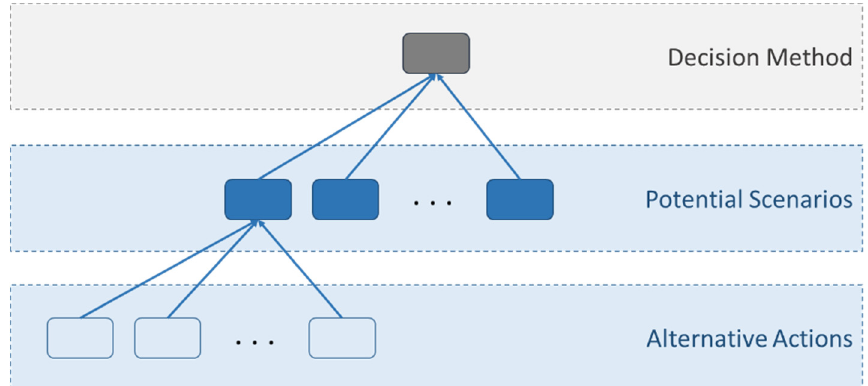
Figure 3. Decision making based on the evaluation of each action-scenario